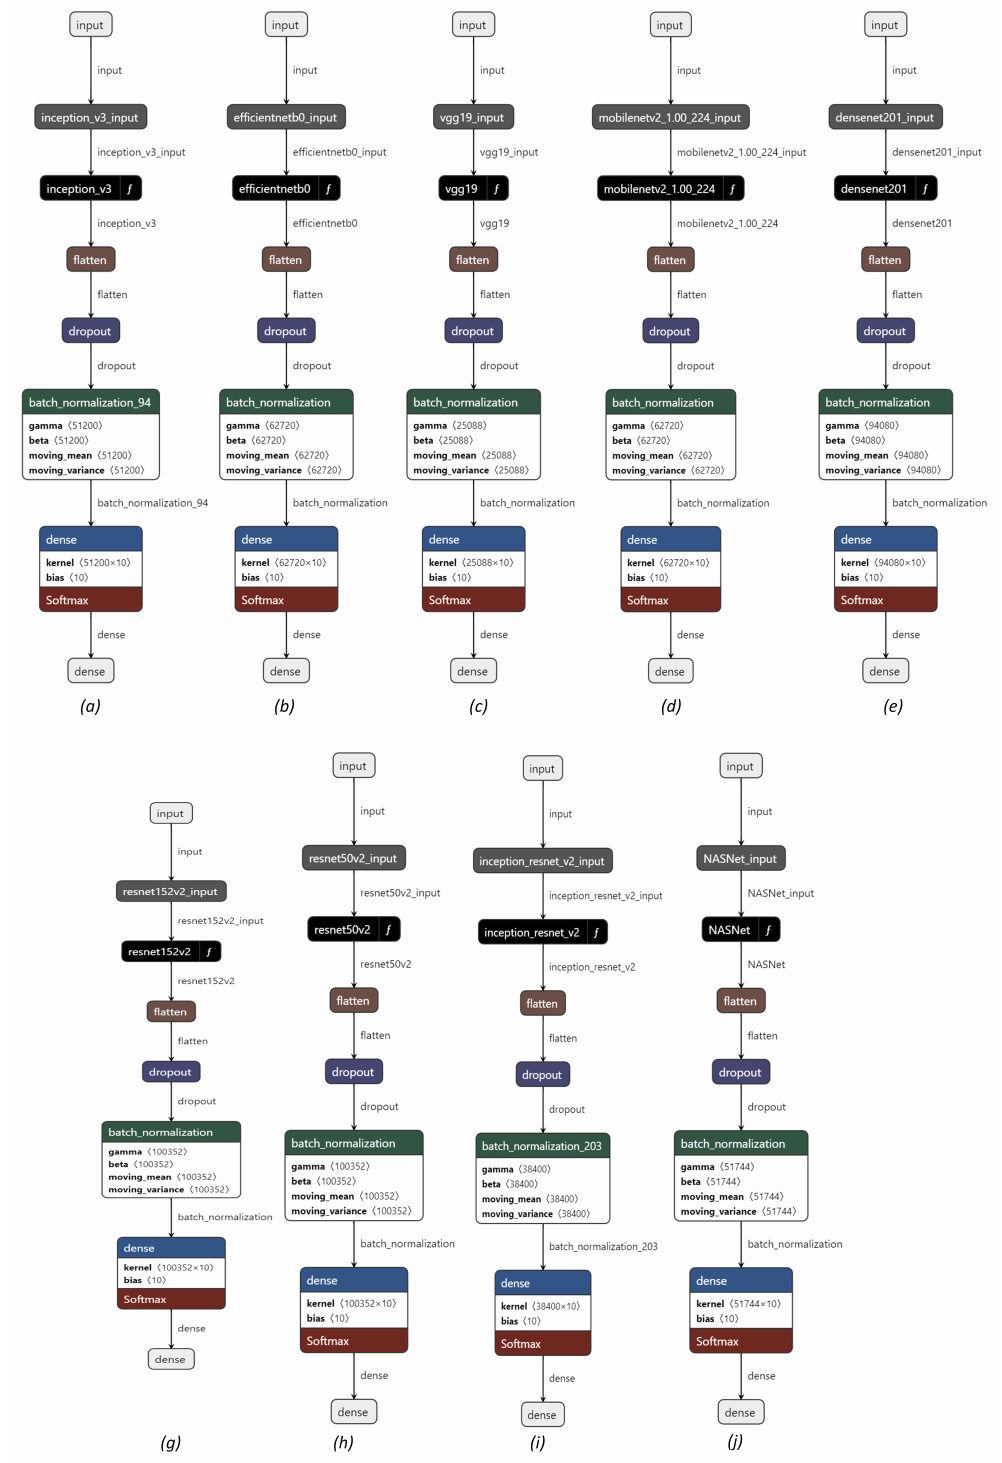
Figure 2. Modified blocks of pre-trained models after fine-tuning processes: ( a )-InceptionV3, ( b )-EfficientNetB0, ( c )-VGG19, ( d )-MobileNetV2, ( e )-DenseNet201, ( g )-ResNet152V2, ( h )-ResNet50V2, ( i )-InceptionResNetV2, and ( j )-NasNetMobile. Where f refers to the basic pre-trained architecture in these